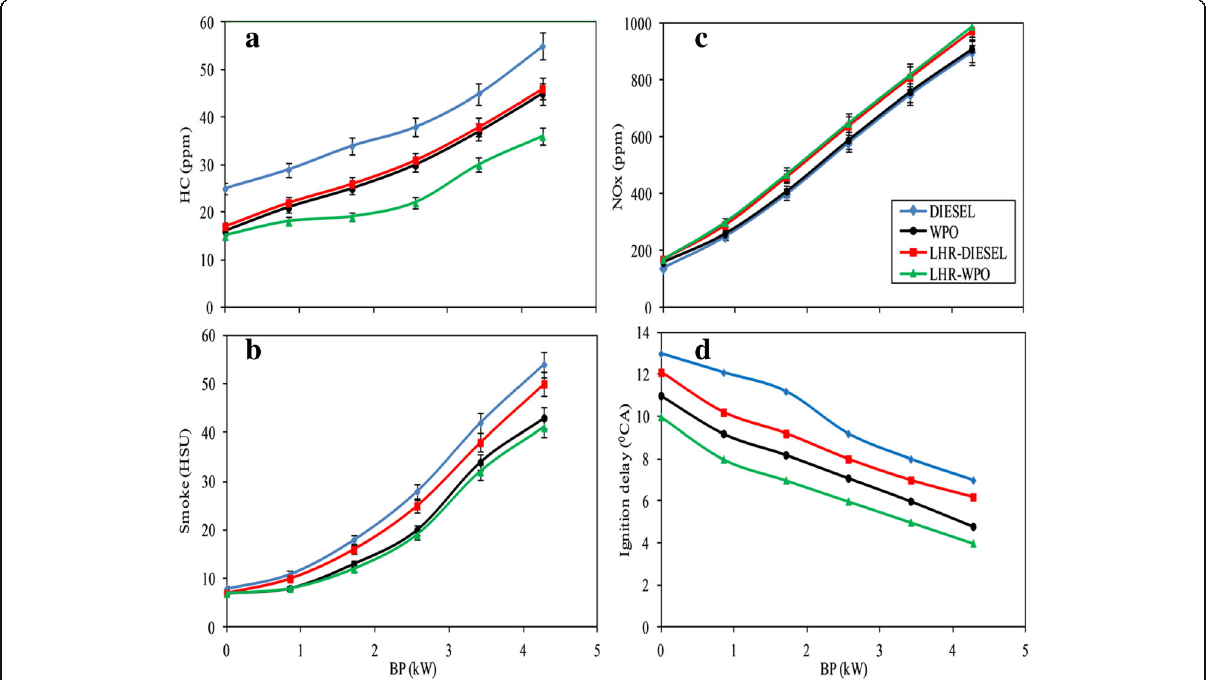
Fig. 3 Performance evaluation as a function of BP for all test fuels on coated and uncoated engines ( a ) HC, ( b ) Smoke, ( c ) NO x and ( d ) ignition